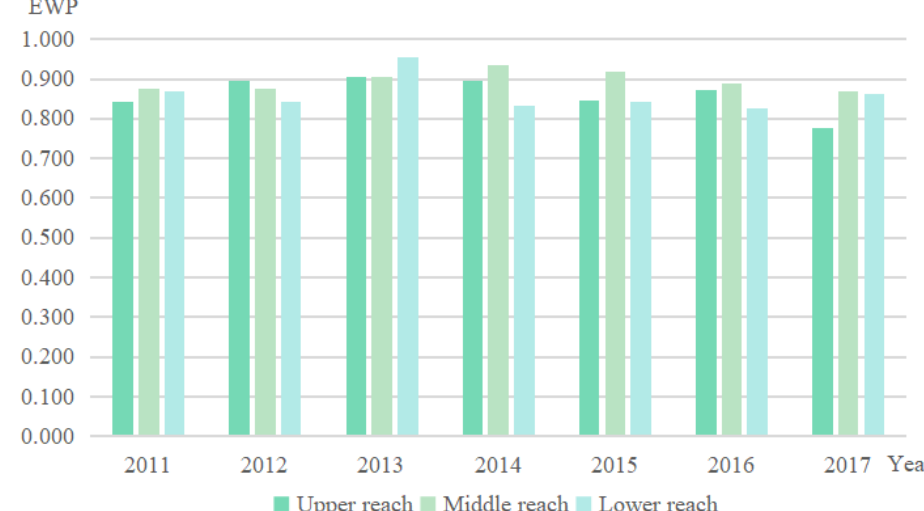
Figure 4. The EWP of the three reaches in the Yellow River Basin from 2011 to 2017.